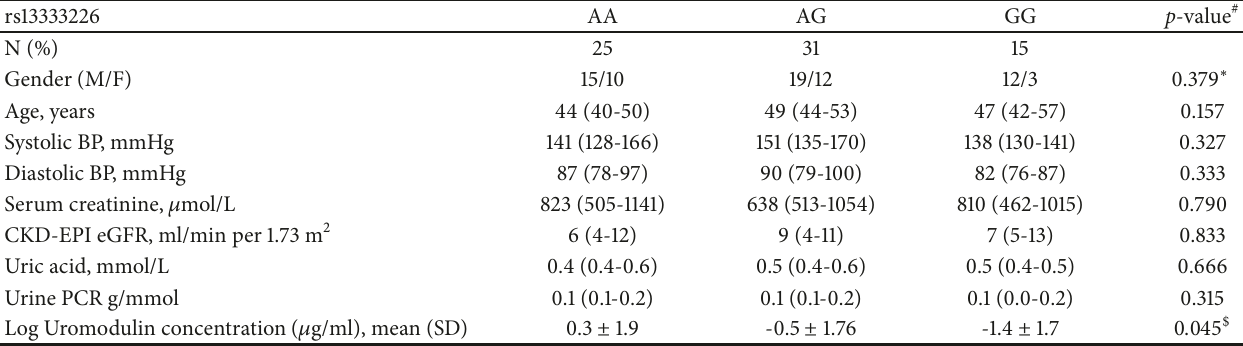
Table 3: Relationship between rs13333226 polymorphisms in the UMOD gene and clinical and demographic features in CKD cases.